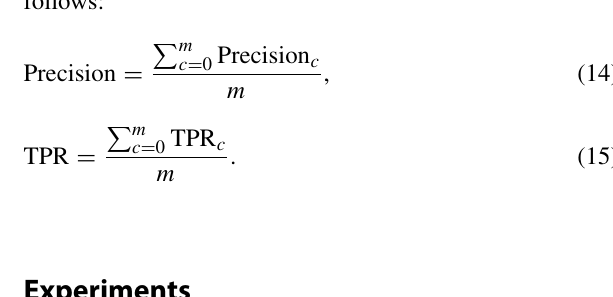
be class c . For all classes pre and TPR can be expressed